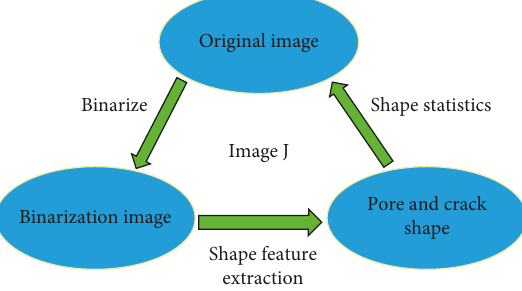
Figure 12: Schematic diagram of pore and crack shape